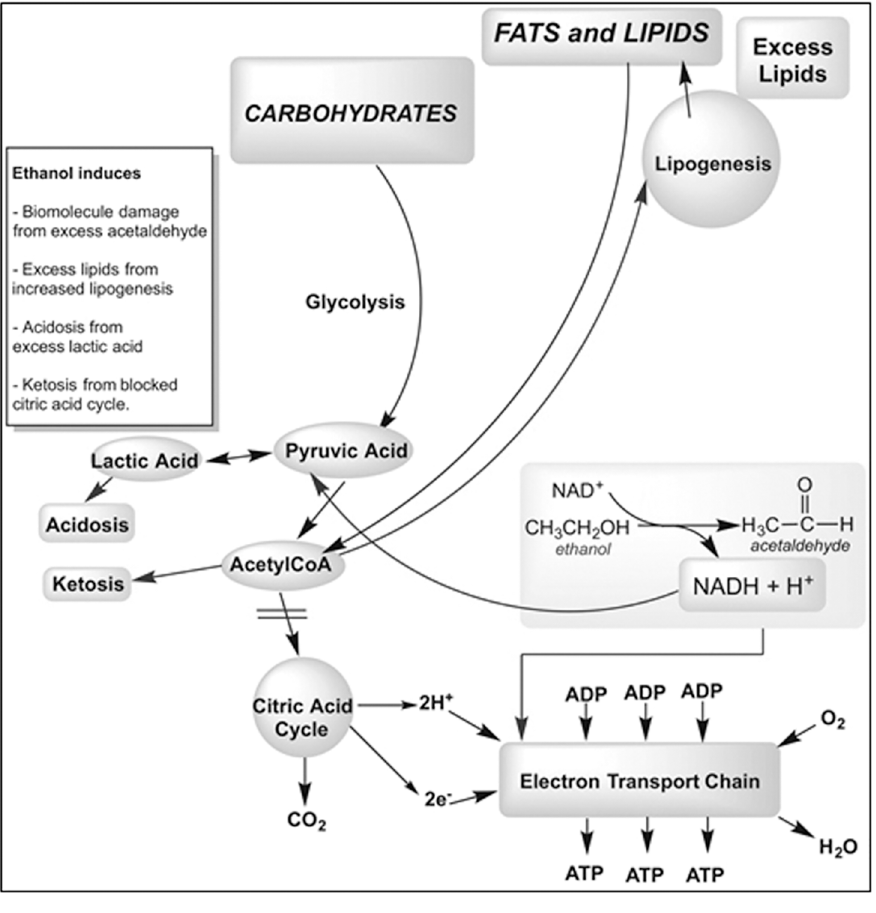
Figure 4. Ethanol metabolism in cells from premutation carriers. Ethanol is normally me- tabolized to acetate by generating NADH. Excess of [NADH]/[NAD + ] promotes lactate formation, inhibits Kreb’s cycle, favors ketogenesis and lipogenesis from excess of acetylCoA that did not enter the Kreb’s cycle. These effects are all compounded in a background exhibiting a mitochondrial